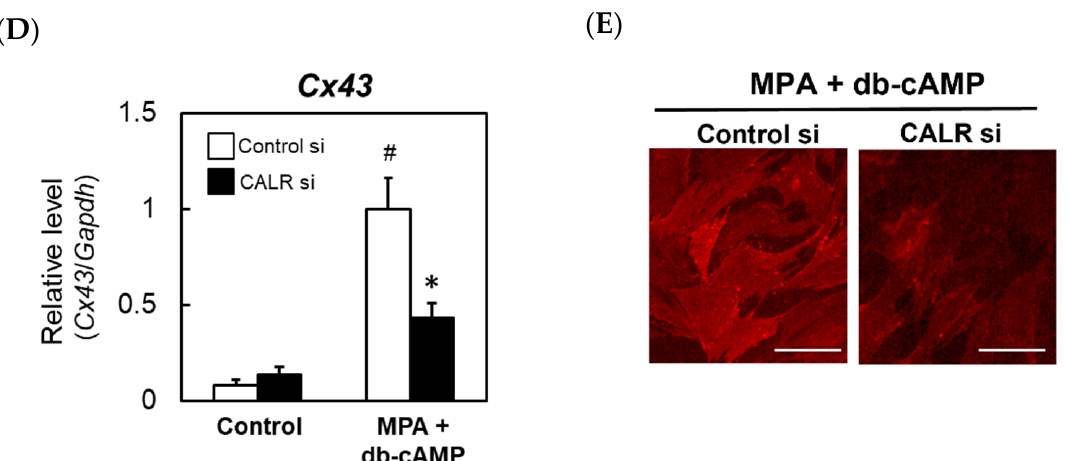
Figure 4. The effects of knocking down calreticulin (CALR) on the expression levels of decidual markers in an in vitro rat decidualization model. Rat ESCs were treated for 24 h with a non-targeting control (Cont) or CALR-specific siRNA and then cultured for an additional 24 h. Immunoblot analysis of CALR expression ( A ). The viabilities of rat ESCs transfected with a non-targeting control or CALR-specific siRNA were assessed using the WST-8 assay ( B ). Real-time RT-PCR analyses of the Prl ( C ), Dtprp ( C ), and Cx43 ( D ) mRNAs in rat ESCs transfected with a non-targeting control or CALR-specific siRNA. At 48 h after the siRNA transfection, cells were co-treated with MPA (100 nM) and db-cAMP (500 μ M) for a further 48 h. Total RNA was then extracted from the cells and subjected to real-time RT-PCR. The expression level of Gapdh was used as an internal control. Data represent the mean ± SEM of three independent experiments. # p < 0.01 versus Control; * p < 0.01 versus Control siRNA. Immunocytochemical analysis of Cx43 in rat ESCs transfected with a non-targeting control or CALR-specific siRNA ( E ). Scale bar = 100 mm.